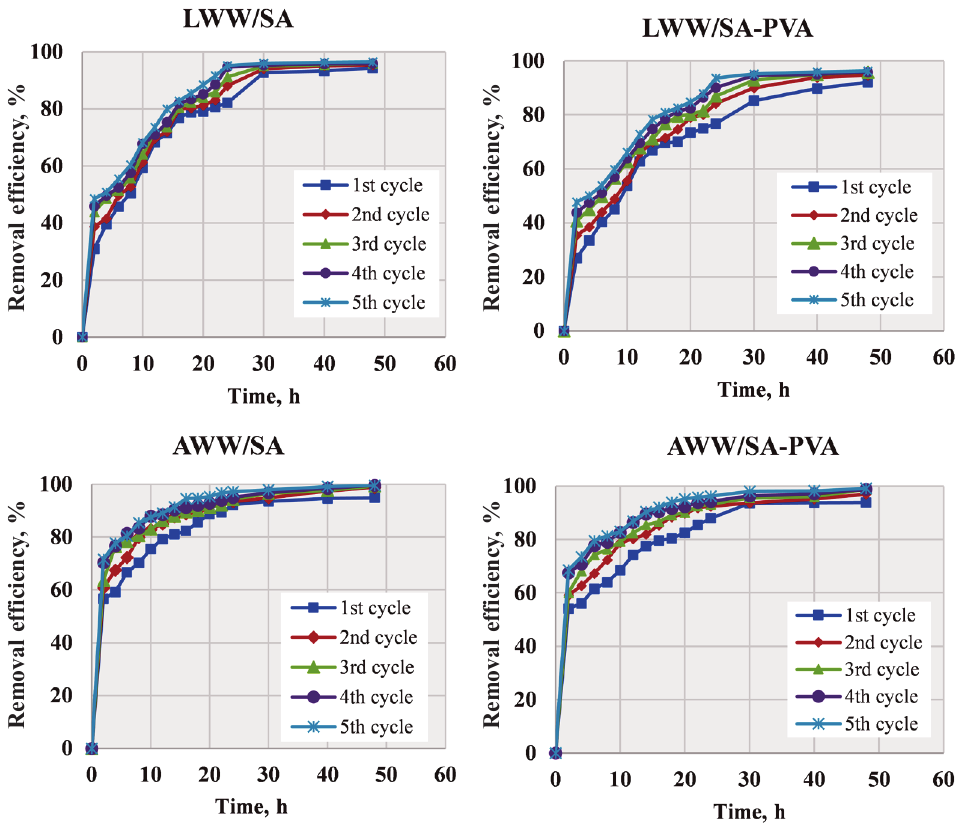
Fig. 5 – Recycling of SA and SA-PVA beads for SDS biodegradation in LWW and